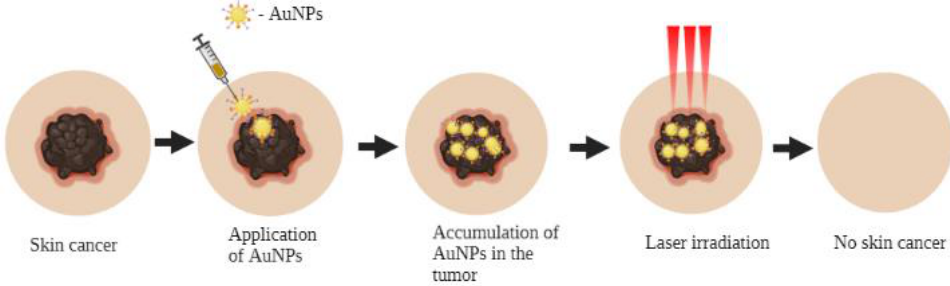
Figure 5. Schematic illustration of PTT on skin cancer (created with